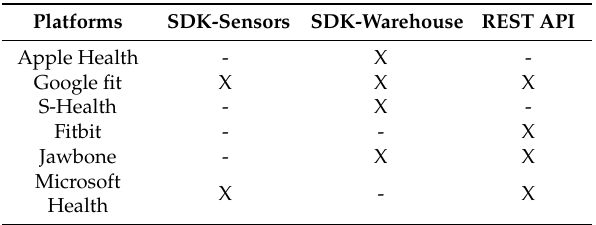
Table 1. Systems and options available in wearable